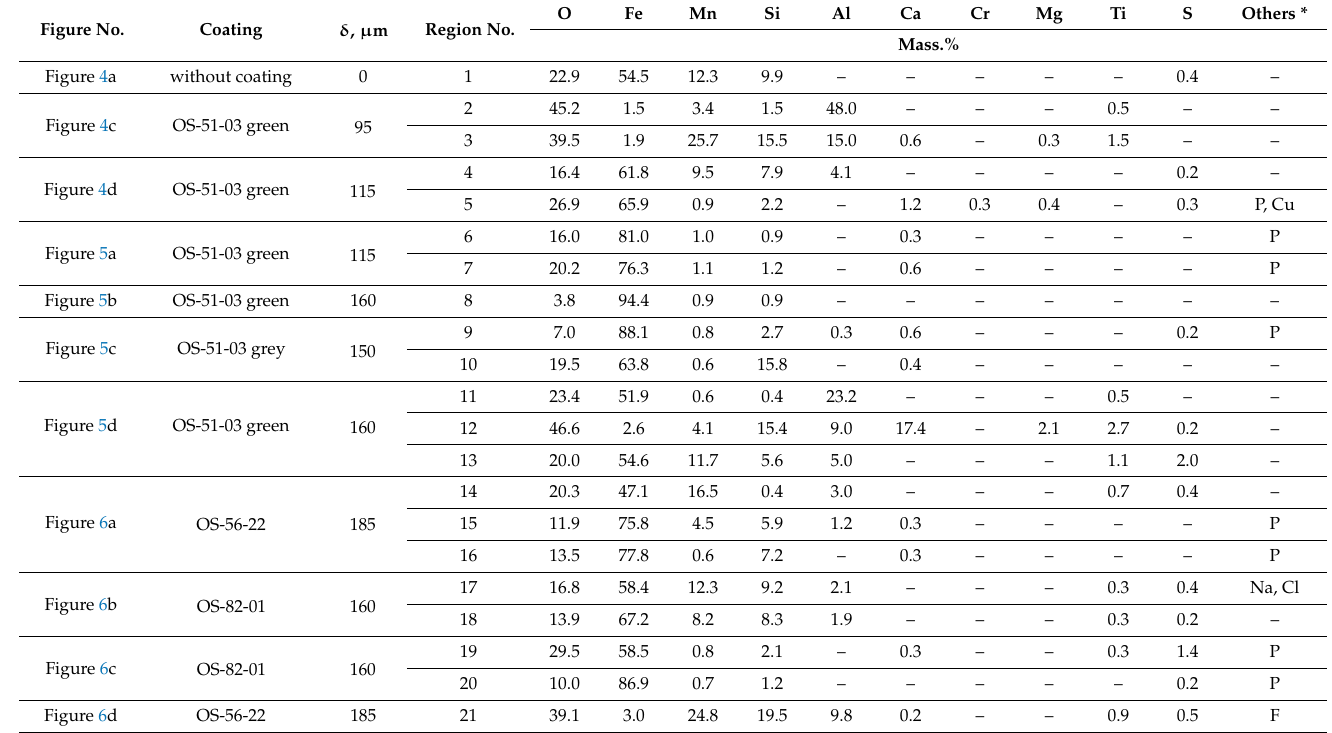
*—due to the fact that the EDS method does not allow for the reliable quantification of the light elements mass fraction up to carbon inclusive, they are not taken into the table.